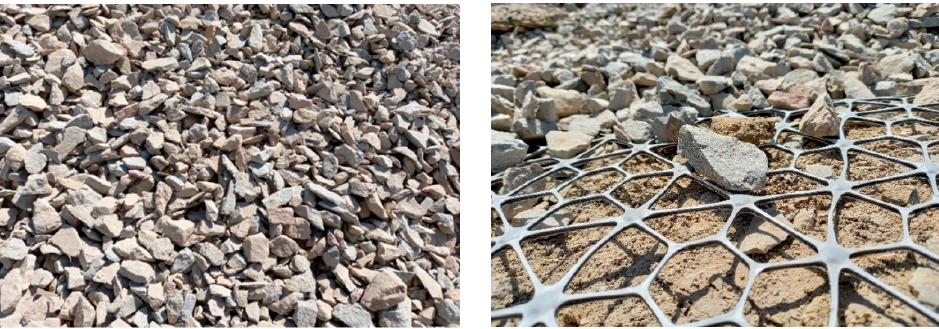
Figure 22. Aggregate ( left ) and geogrid ( right ) used to construct stabilised working platform [139].